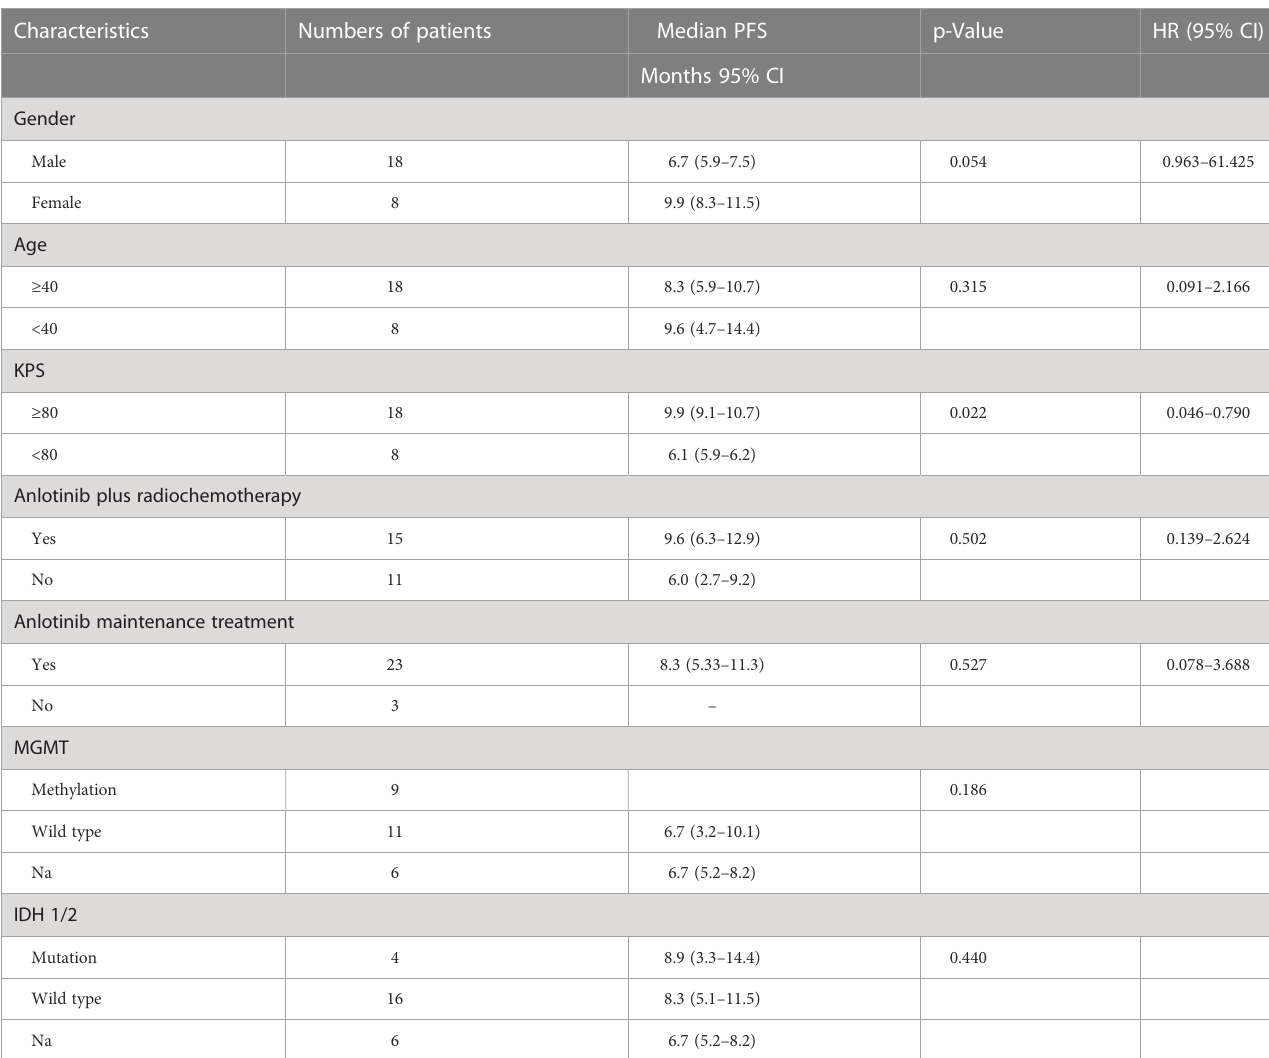
TABLE 3 Multivariate analysis.